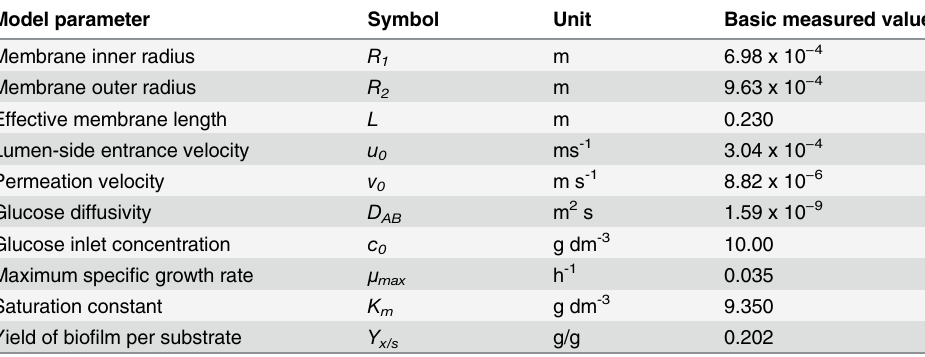
Table 1. Parameter values used to determine the effectiveness factor in Fig 3 [25].